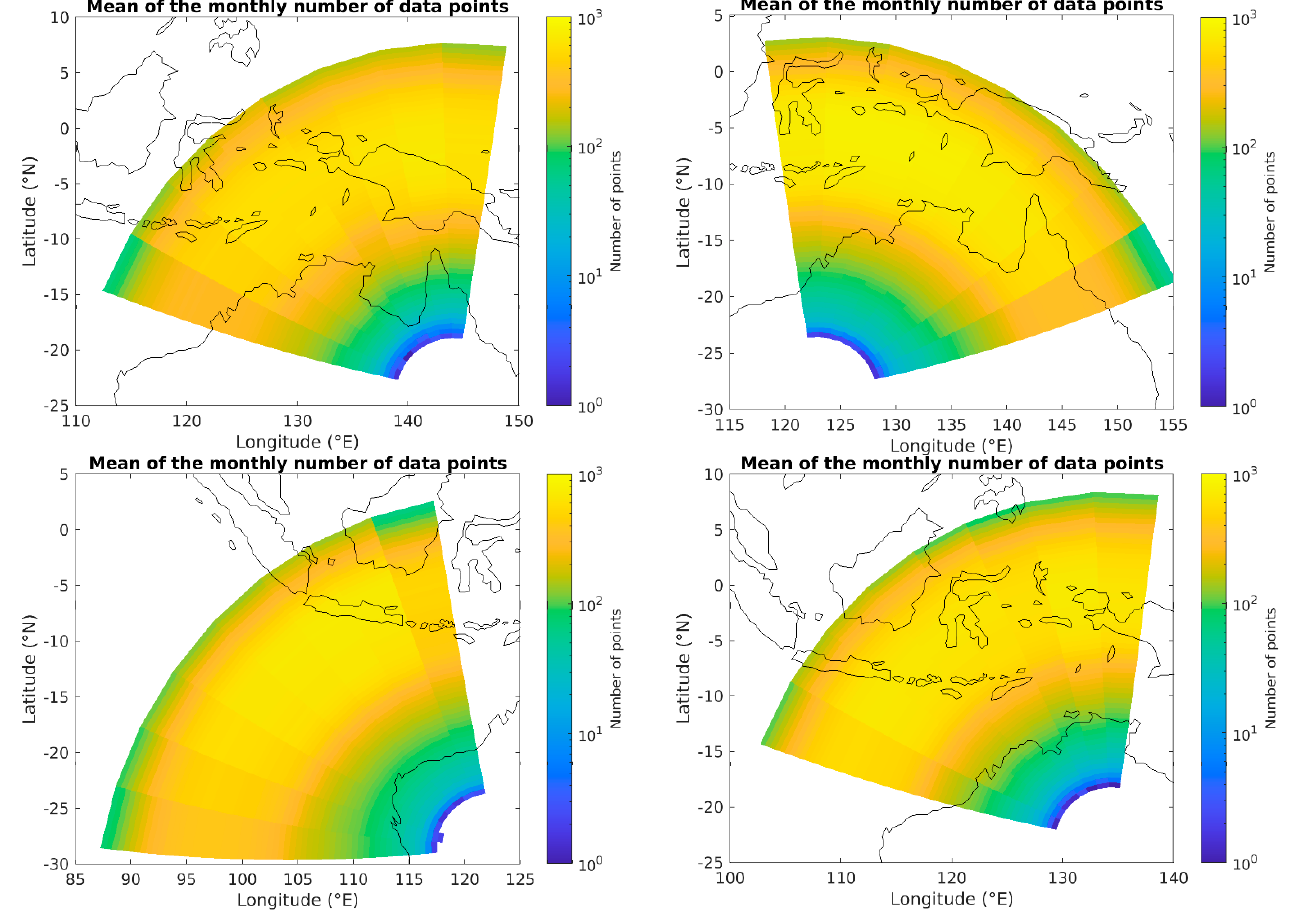
Figure 8. Decade mean number of data points contributing to each monthly backscatter coefficient value for LO ( top left ), LAE ( top right ), LAW ( bottom left ) and AS ( bottom right ).